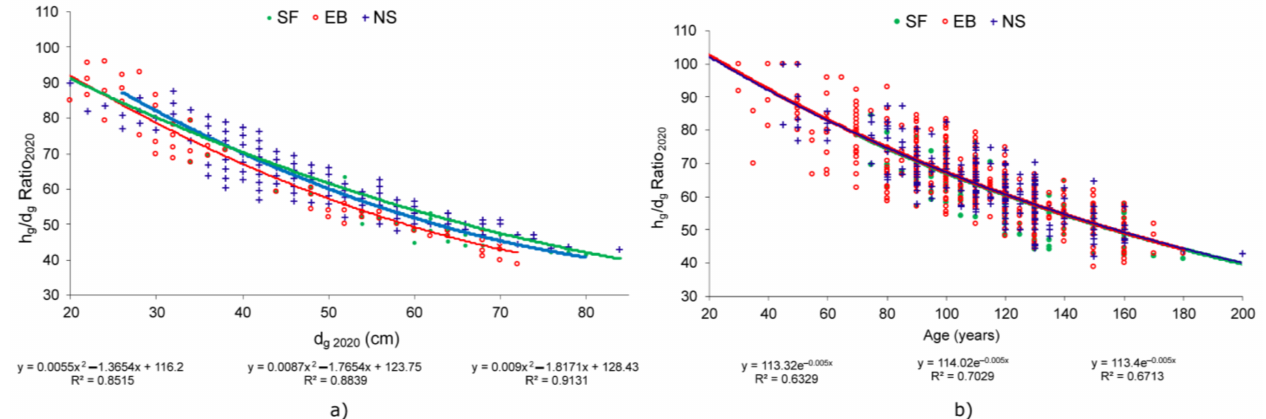
Figure 4. Variation in the mean-tree slenderness index for fir, beech, and spruce from mixed stands in 2020 in relation to the mean diameter of the stands ( a ) and their ages ( b ). The diameter and height of the mean-basal-area tree were used in the calculations (SF—silver fir, EB—European beech, and NS—Norway